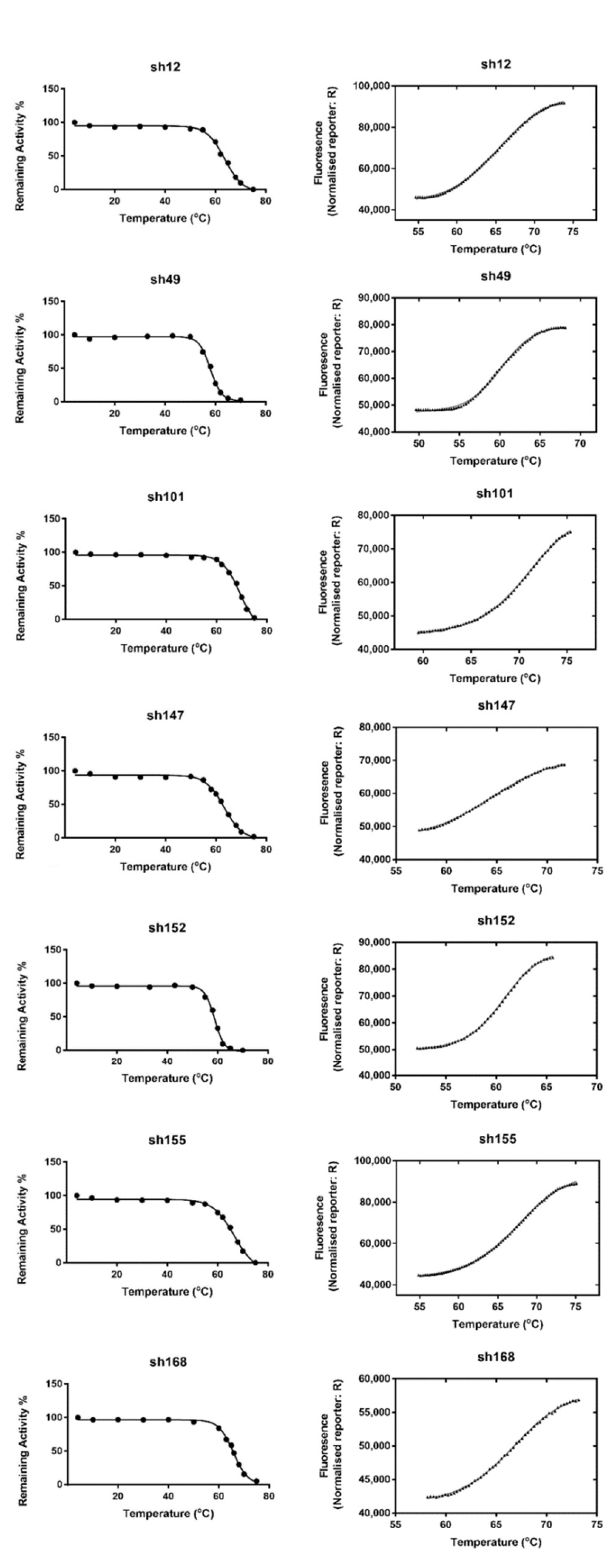
Figure 5. Thermal stability studies of the parent enzymes ( Am GSTF, Lr GSTF, Hv GSTF, Td GSTF). Left column: thermal inactivation curves. The remaining enzyme activities (%) were measured after heat treatment of each enzyme at the indicated temperatures (°C) for 5 min. Right column: Differ- ential scanning fluorimetry normalised curves for the determination of the melting temperature (T m ). The measurements were performed in triplicate and the data represent the mean ± SD (N = 3).